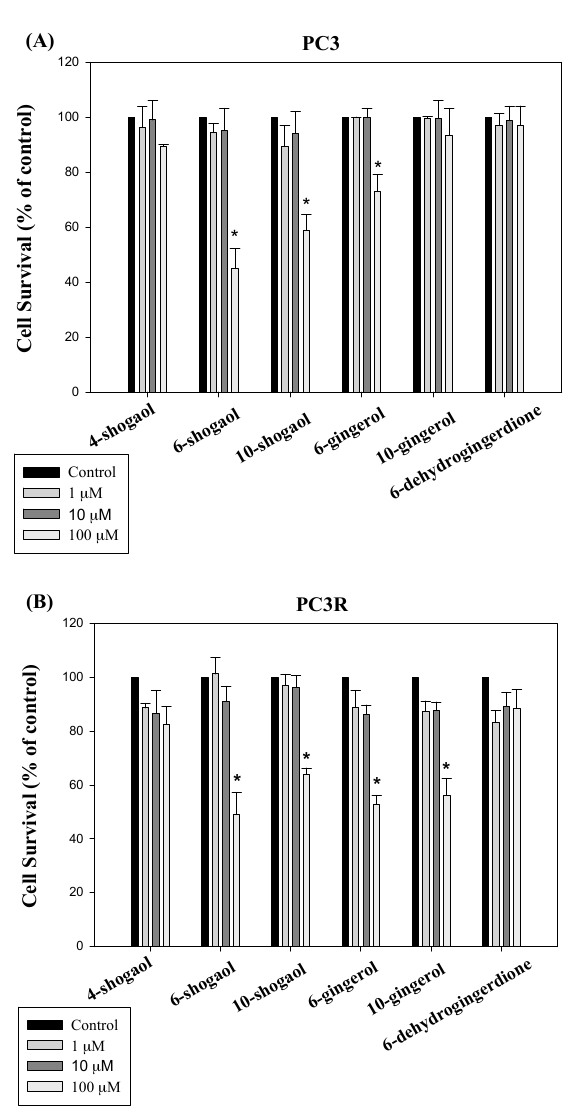
Figure 4. Effects of 4-shogaol ( 1 ), 6-shogaol ( 2 ), 10-shogaol ( 3 ), 6-gingerol ( 4 ), 10-gingerol ( 5 ), and 6-dehydrogingerdione ( 6 ) on PC3 ( A ) and PC3R ( B ) cell viability. These compounds decreased cell viability at 24 h time point. Data were summarized from three independent experiments. * p < 0.05 vs. control group.